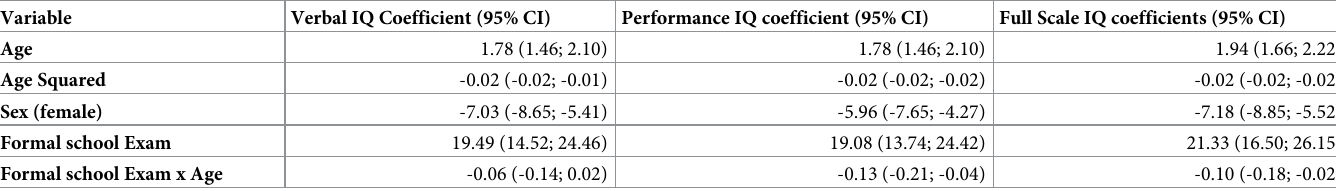
Table 3. Coefficients for growth curve models for Verbal-, Performance-, and Full Scale IQ � .